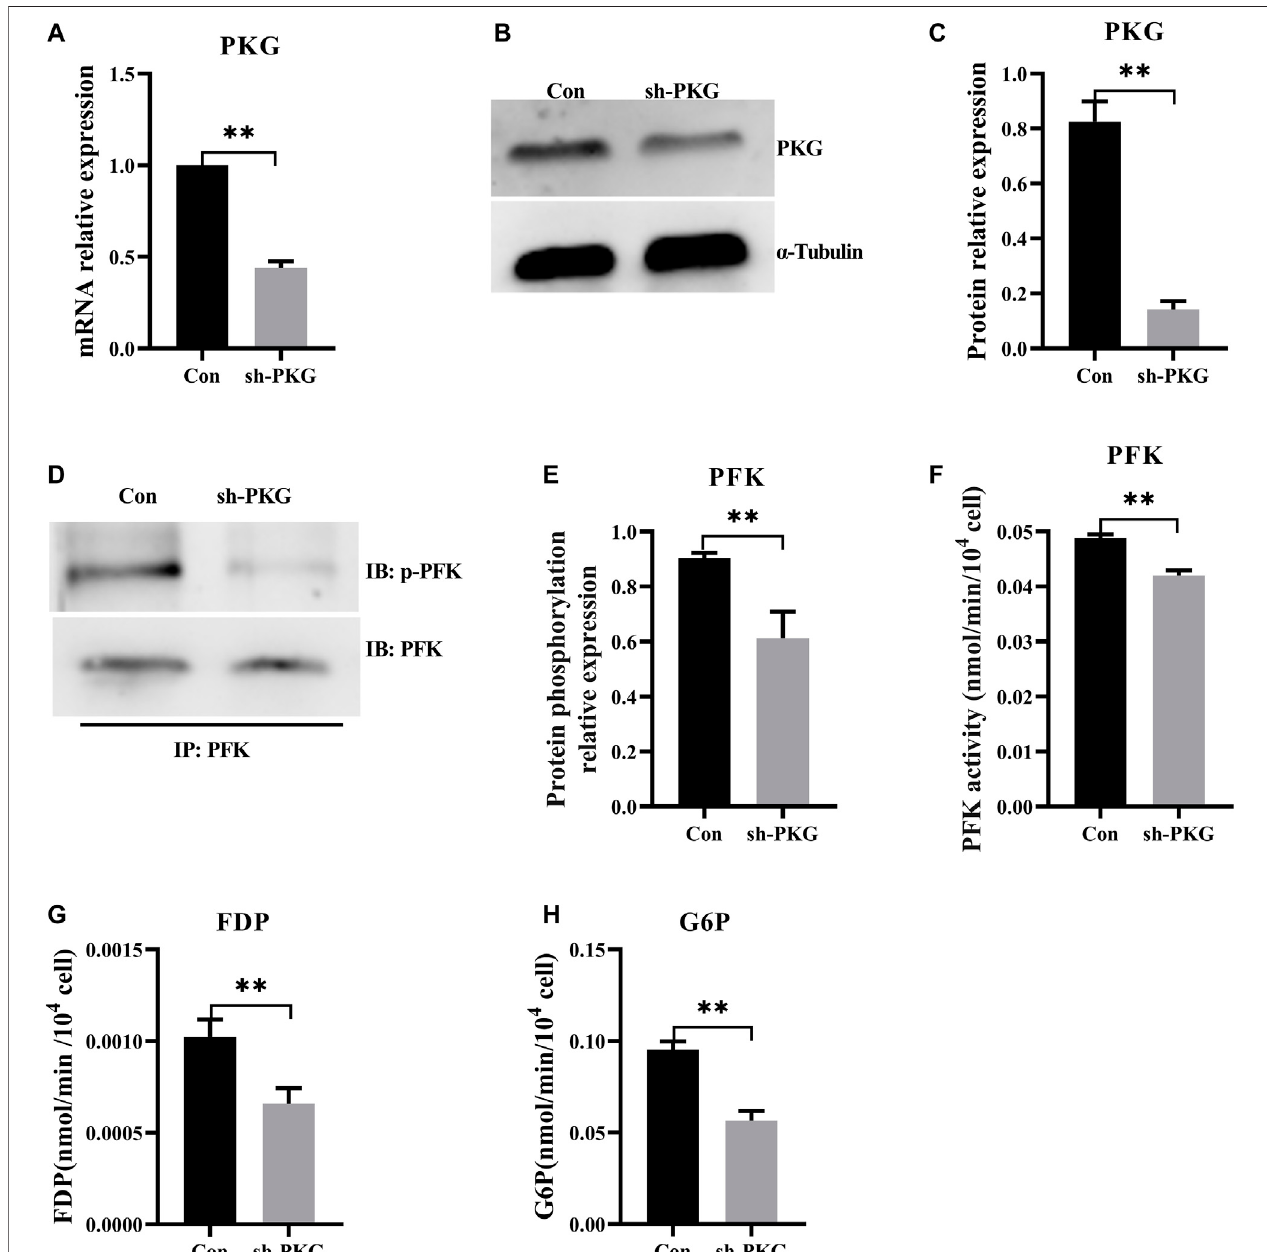
FIGURE 6 | Knockdown of PKG inhibited glycolysis via decreasing phosphorylation of PFK. (A – C) The expressions of PKG at the mRNA and protein levels after knockdownof PKG inthe H9C2 cells. (D,E) Phosphorylationlevel ofPFKprotein byimmunoprecipitation ofthe PKG knockdown H9C2 cells. (F) Enzymeactivity ofPFK assay in PKG knockdown H9C2 cells. (G,H) FDP and G6P, the key metabolites in glycolysis, assayed respectively. Abbreviations: PFK, phosphofructokinase; FDP, Fructose-1,6 diphosphate; G6P, Glucose-6-phosphate. All data are presented as mean ± SD. Compared with the control group, * p < 0.05, ** p < 0.01, ns: no signi fi cant; t -tests were used to calculate the p